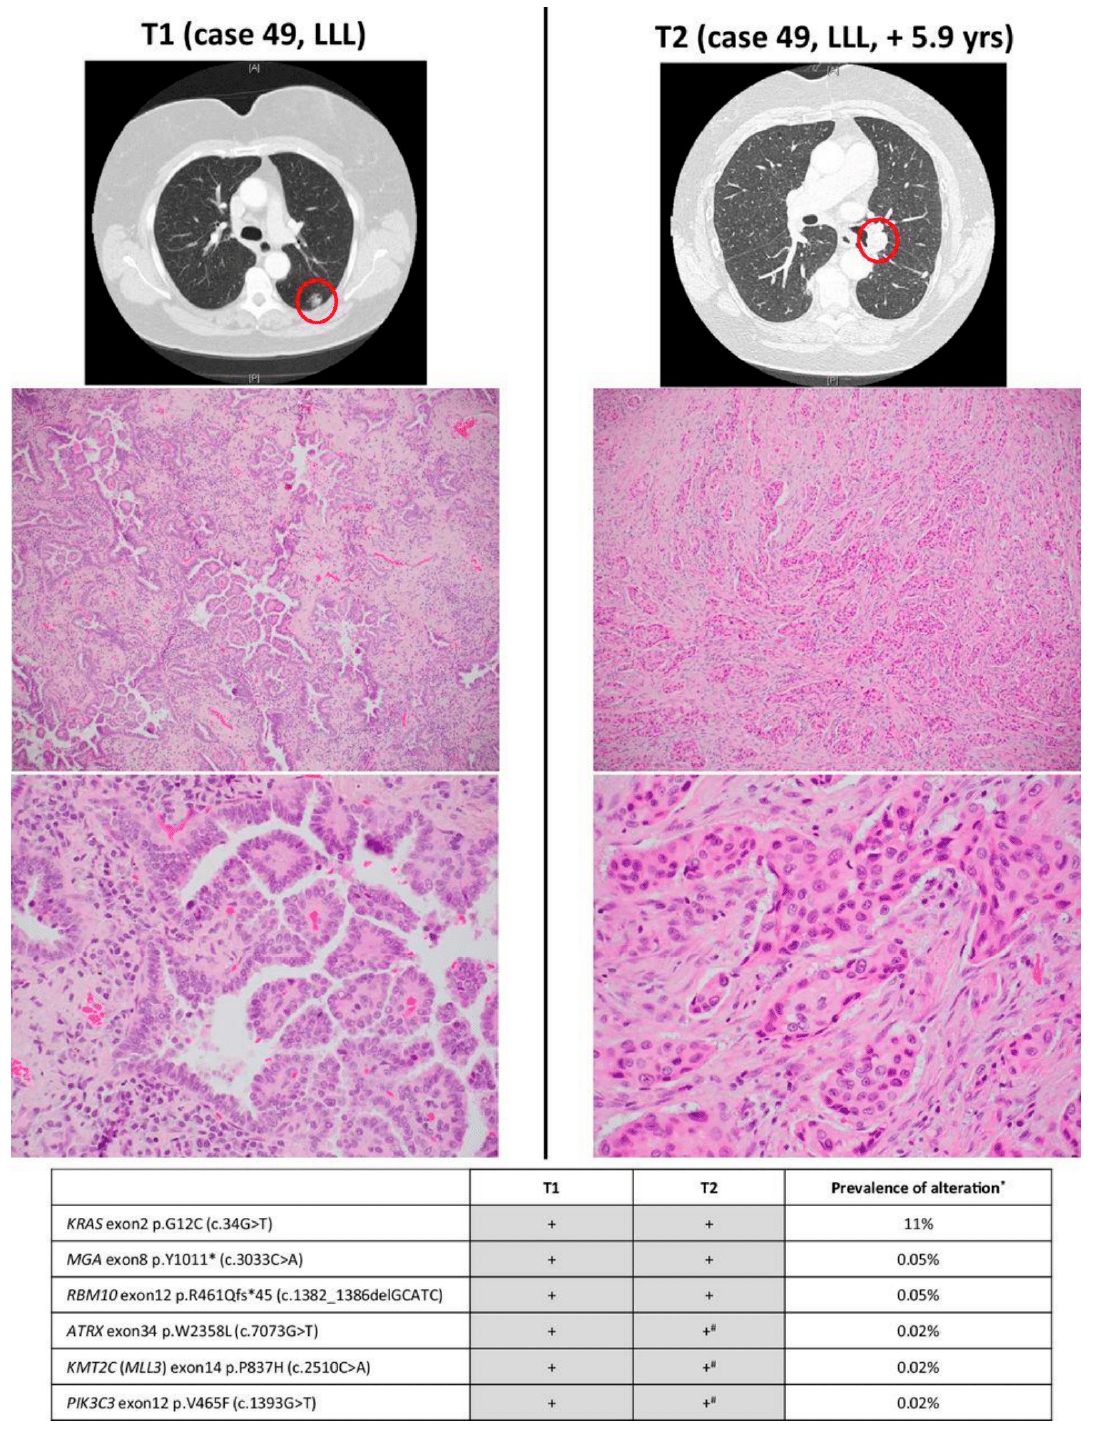
Figure 6. Radiologic and pathologic appearances and next-generation sequencing profile of an intrapulmonary metastasis, showing histologic progression consisting of entirely solid pattern. #, mutations present (subthreshold) in T2 on manual review *; prevalence is based on MSK-IMPACT results for 4119 non-small cell lung cancers in the cBioPortal database. On